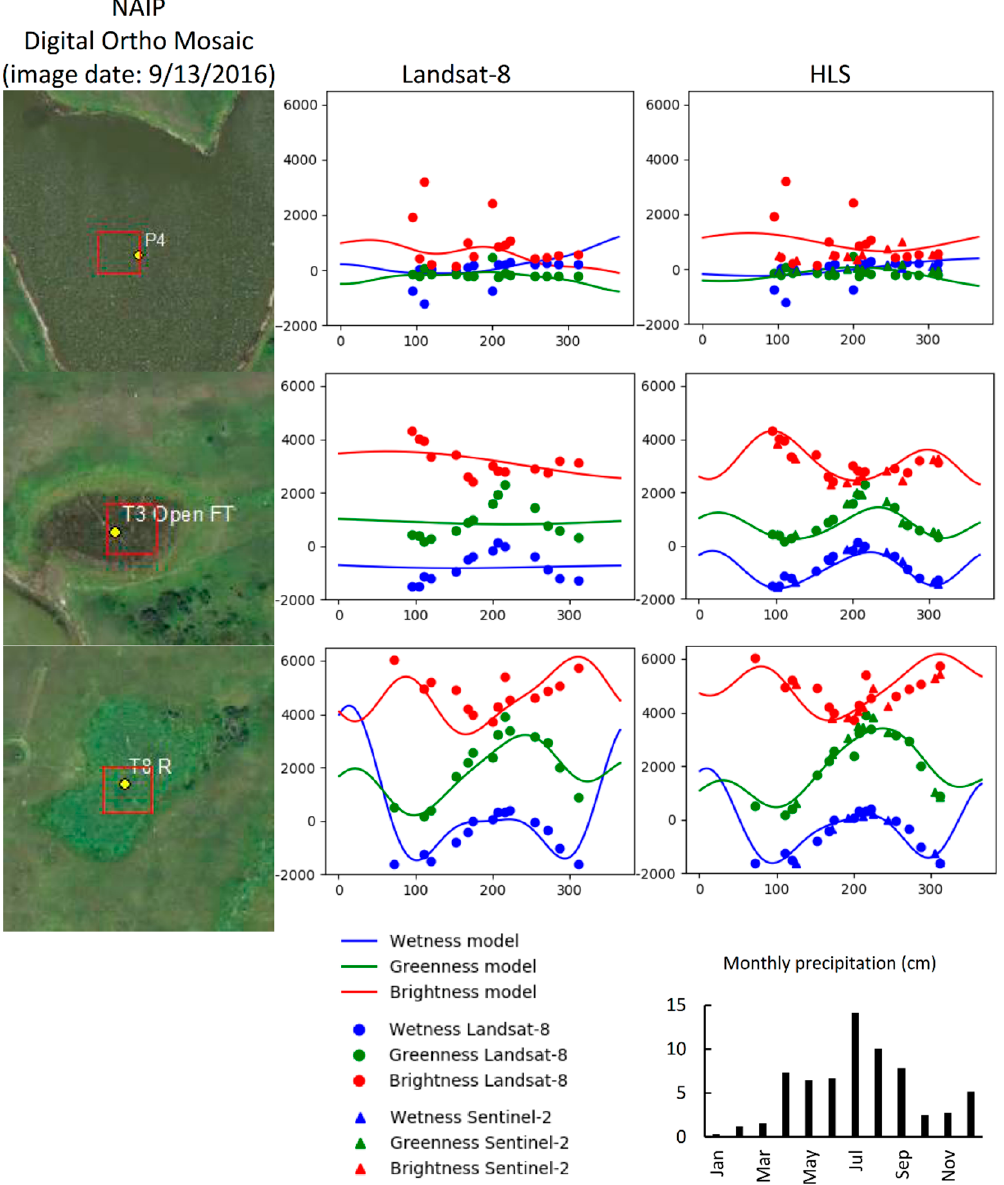
Figure 11. Seasonal tasseled cap (TC) profiles for three wetland sites: P4 permanent lake, T3 open flow-through wetland, and T8 recharge wetland. The scatterplots represent all available clear observations for a single pixel within each wetland. The lines are model-produced daily TC values. The CCDC model types produced for P4 were: annual + intra-annual bimodal and trimodal (full model) for Landsat-8 and HLS. Model types produced for T3 were: no seasonal model for Landsat-8 and full model for HLS. The model types produced for T8 were: full model for both Landsat-8 and HLS. The background images are from the National Agriculture Imagery Program (NAIP; 13 September 2016) [40]. The red box shows the extent of selected pixels. The bar plot shows monthly average precipitation for the county [23] and is included to enhance interpretation of the changes in the bands of the TC profiles.